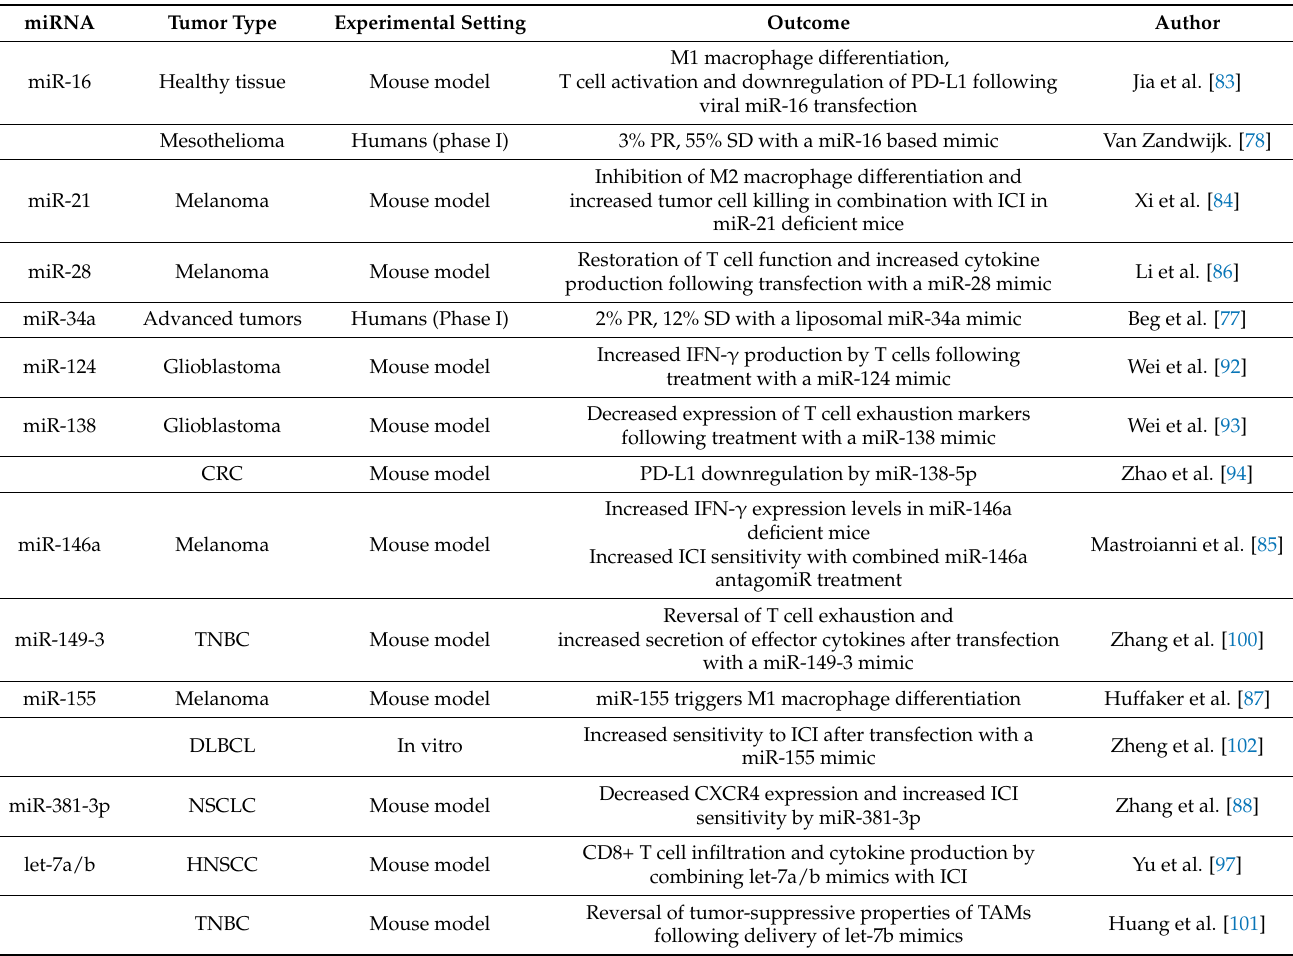
CRC: colorectal cancer, DLBCL: diffuse large B cell lymphoma, HNSCC: head and neck squamous cell carcinoma, ICI: immune-checkpoint inhibitor, IFN- γ : interferon- γ , miR: microRNA, NSCLC: non-small cell lung cancer, PR: partial remission, SD: stable disease, TAMs: tumor-associated macrophages, TNBC: triple-negative breast